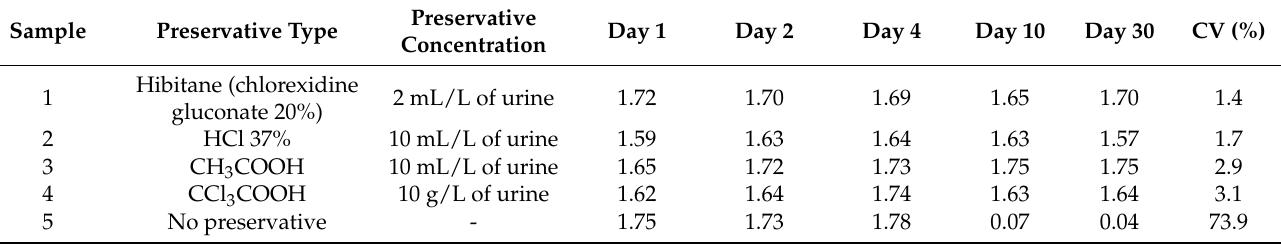
Table 4. Urinary citrate stability, 4 ◦ C